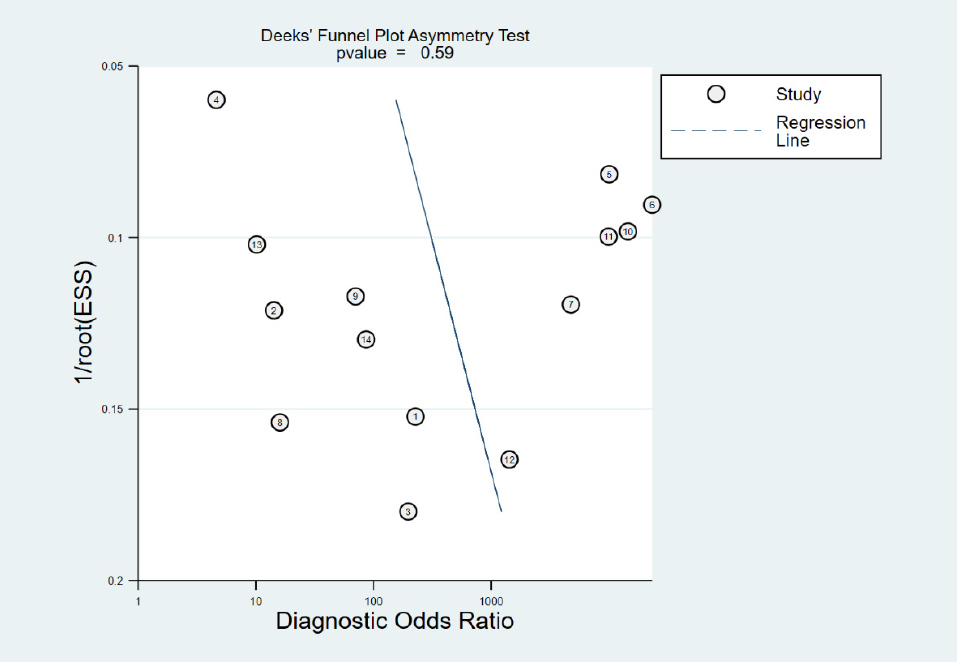
Figure 5. Deek’s funnel plot for the evaluation of potential publication bias. The possibility of publication bias was low.